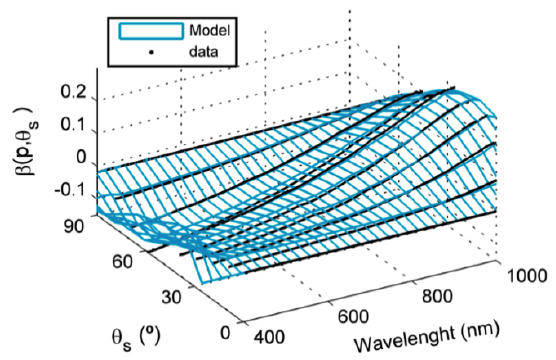
Figure 5. Cosine receptor directional response correction factor β ( θ s ). Fit model and measured data.